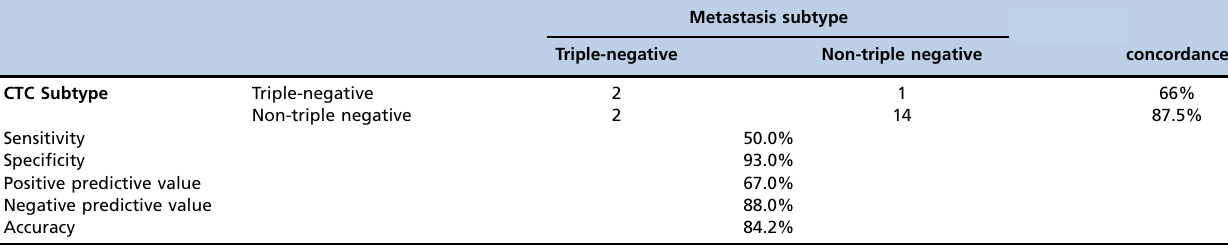
Table 5 - Correlation between CTC and metastasis subtypes classified as TN and